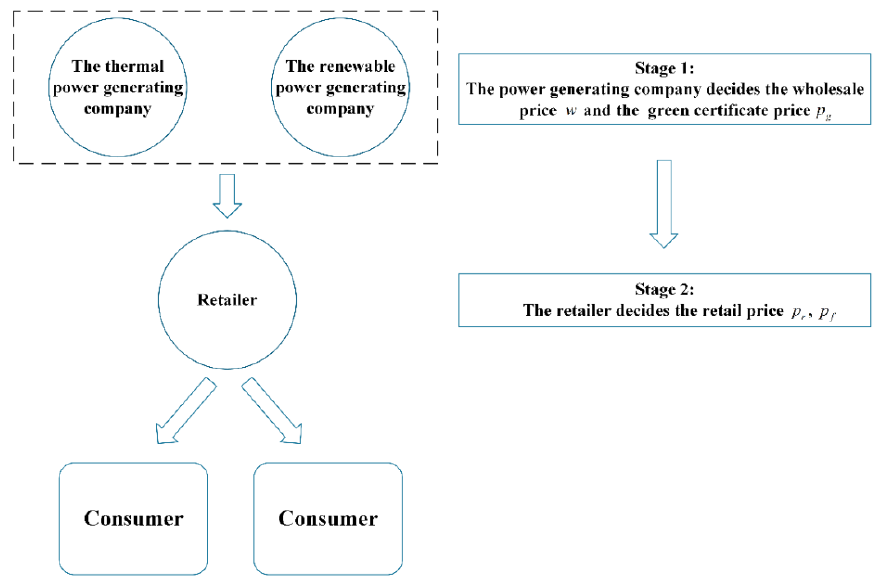
Figure 3. The supply chain network structure of the centralized decision in case 3 160